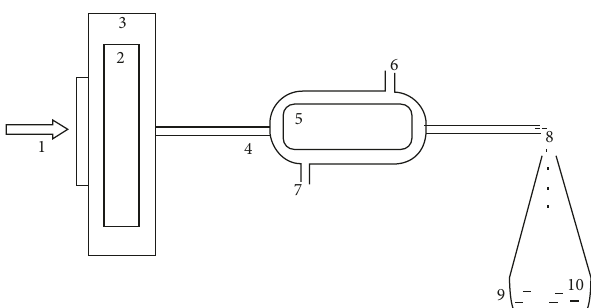
Figure 1: Schematic representation of the pyrolysis.1, feedstock; 2, pyrolytic chamber; 3, furnace; 4, chamber rod; 5, condenser; 6, cold water inlet; 7, cold water outlet; 8, emitted gas; 9, conical flask; 10, pyrolytic